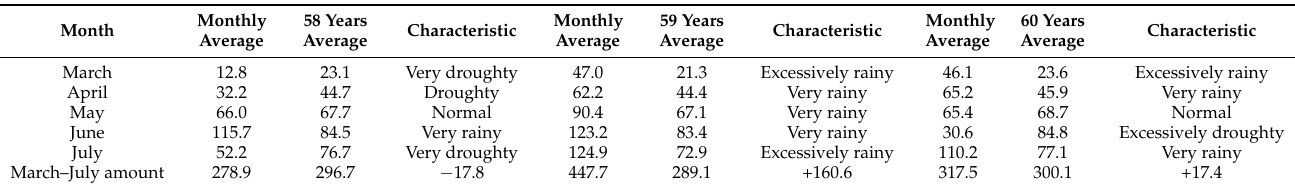
Table 3. ARDS Turda rainfall (mm) during